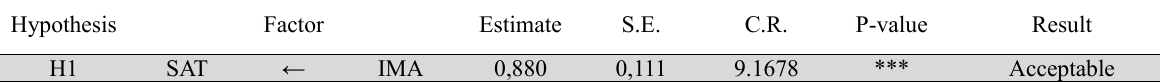
Coefficients of regression model SEM and test results of the model’s hypotheses